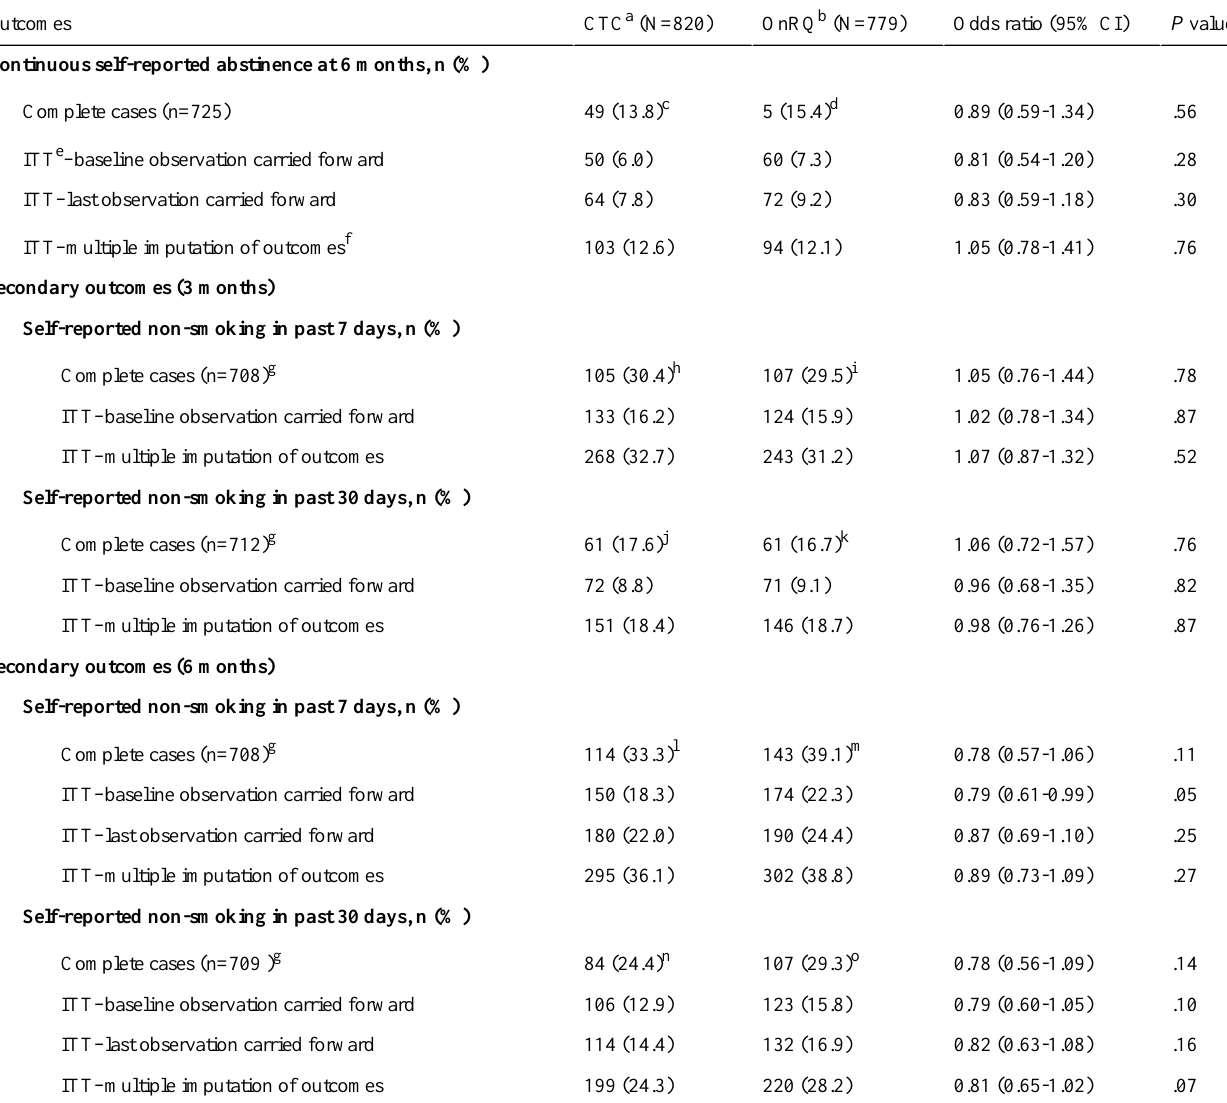
P valueOdds ratio (95% CI)OnRQ b (N=779)CTC a (N=820)Outcomes